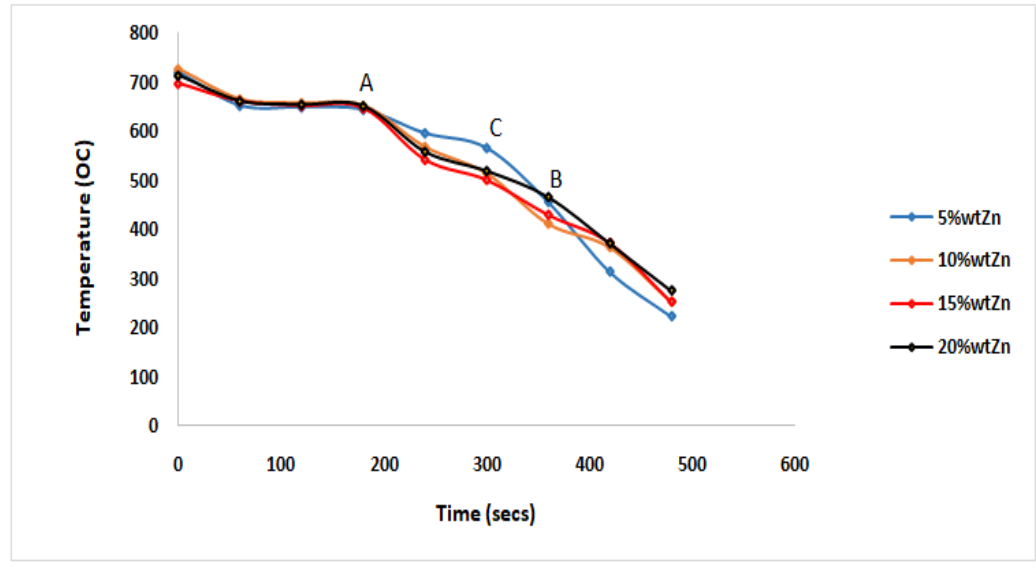
Fig. 2. Cooling curves for Al-Cu alloy